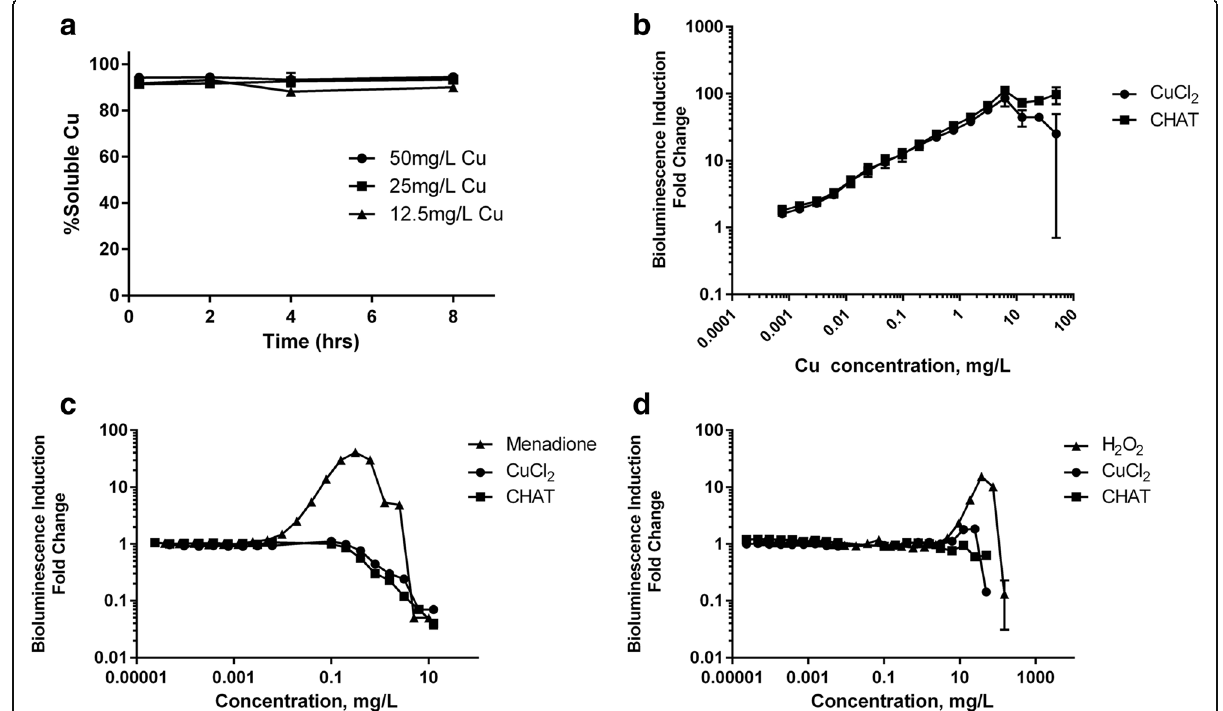
Fig. 3 a Dissolution profile of CHAT in supplemented HMM at 12.5, 25, and 50 mg/L copper. Dose-response of bioluminescence induction of recombinant luminescent bacteria: b intracellular copper ion-responding E. coli MC1061 pSLcueR/pDNPcopAlux bacteria, c DNA damage-responding E. coli MC1061 (pDEWrecAlux), and d superoxide anion-responding E. coli K12::soxRSsodAlux upon exposure for 4 h in supplemented HMM to copper chloride, CHAT (concentration in mg Cu/L), and respective controls (menadione in c and H 2 O 2 in d )